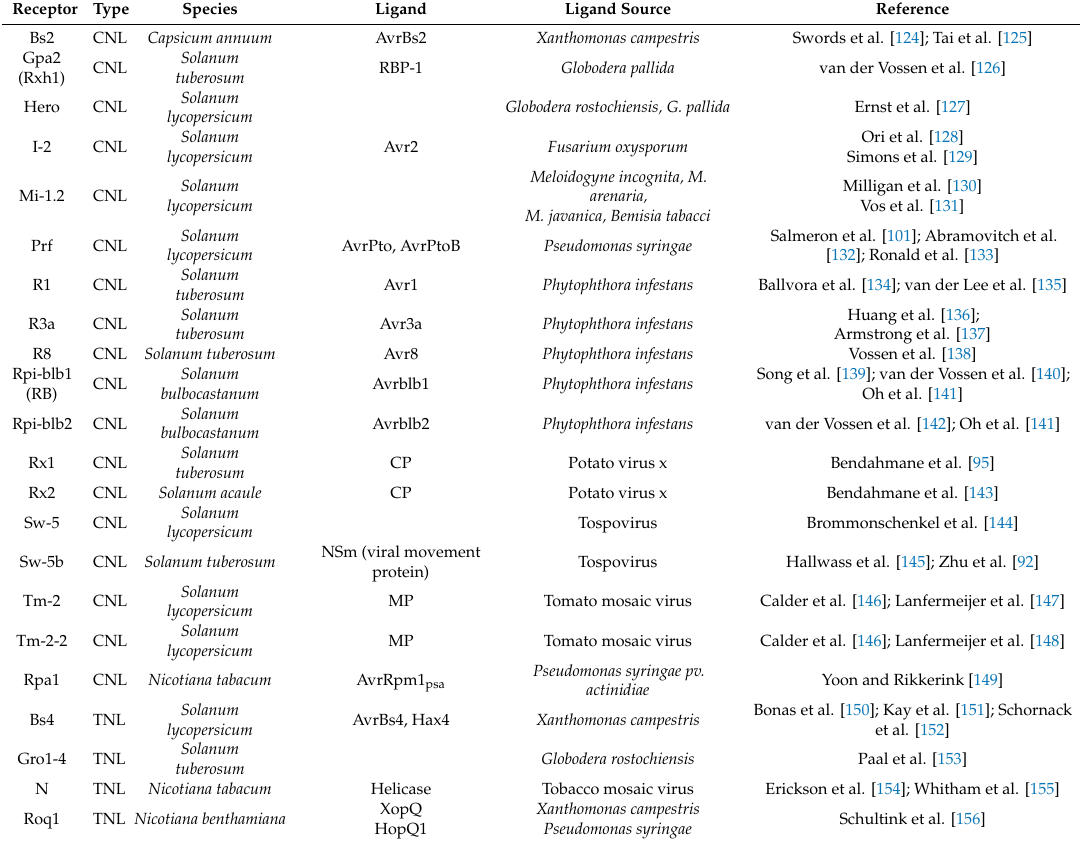
Table 2. Known intracellular immune receptors proteins in plant species of the Solanaceae